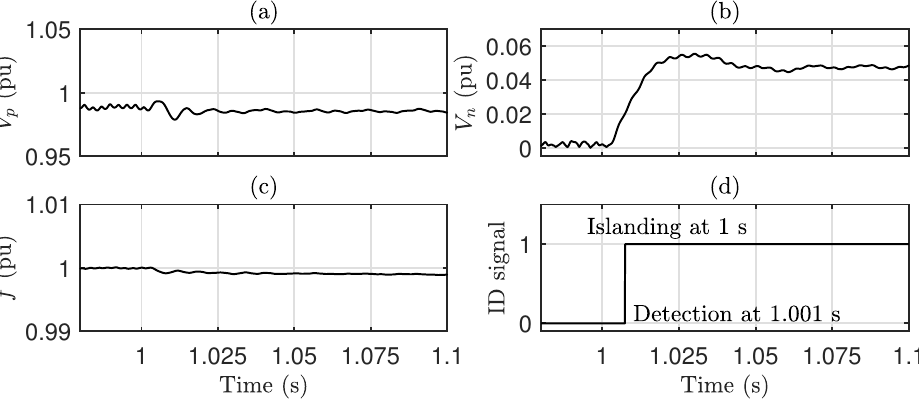
Figure 11. L -type filter case: Performance under 100% increase in filter inductance: ( a , b ) estimated magnitudes of positive- and negative-sequence PCC voltage, respectively; ( c ) estimated frequency; and ( d ) ID